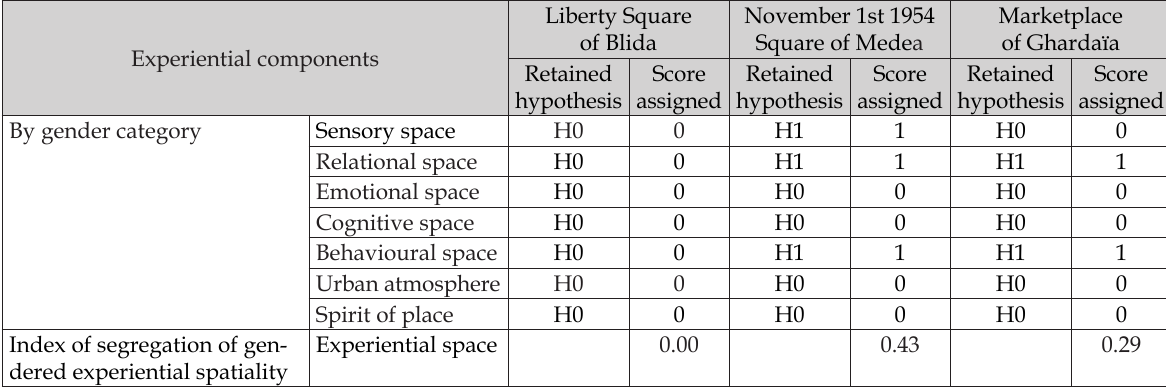
Table 5. Index of spatial and phenomenal segregation of public